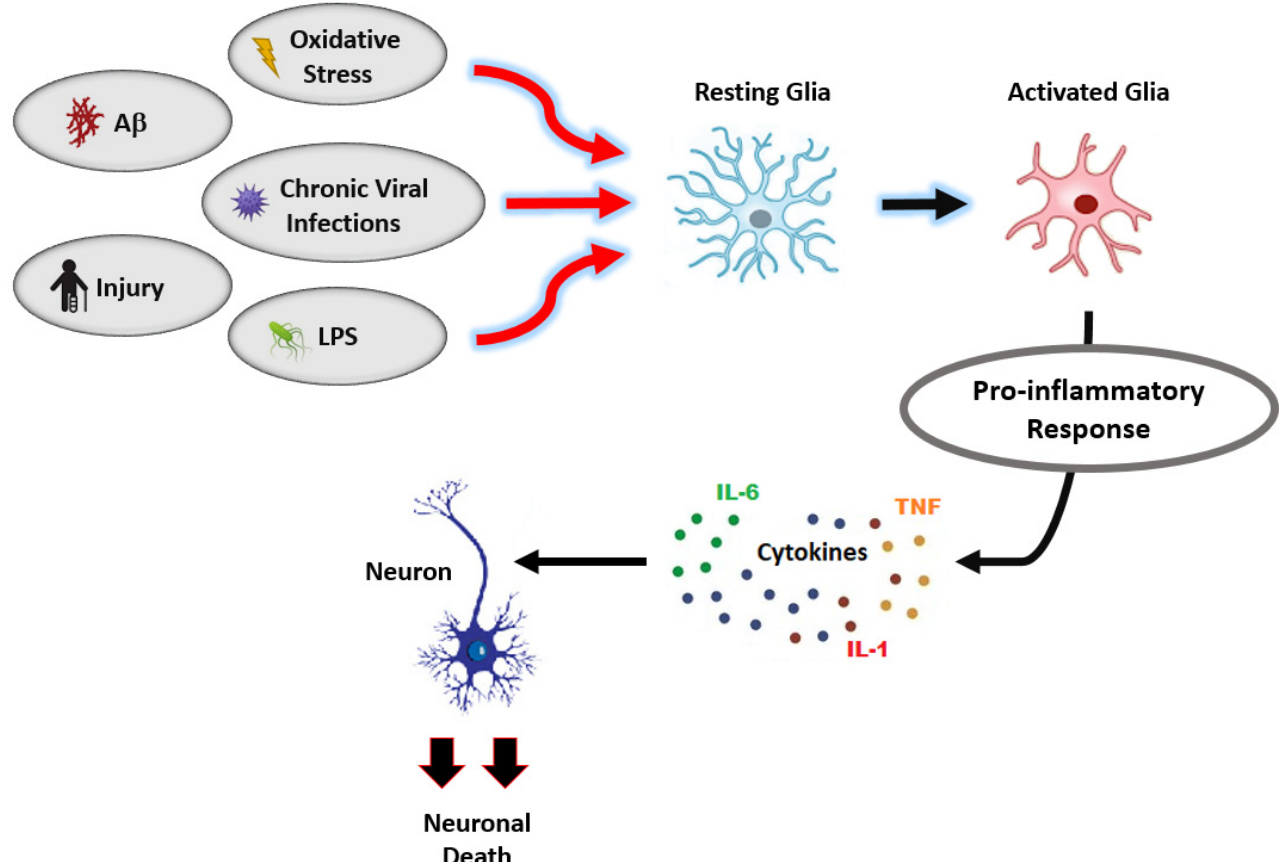
Figure 4. Glial activation leads to neurodegeneration.